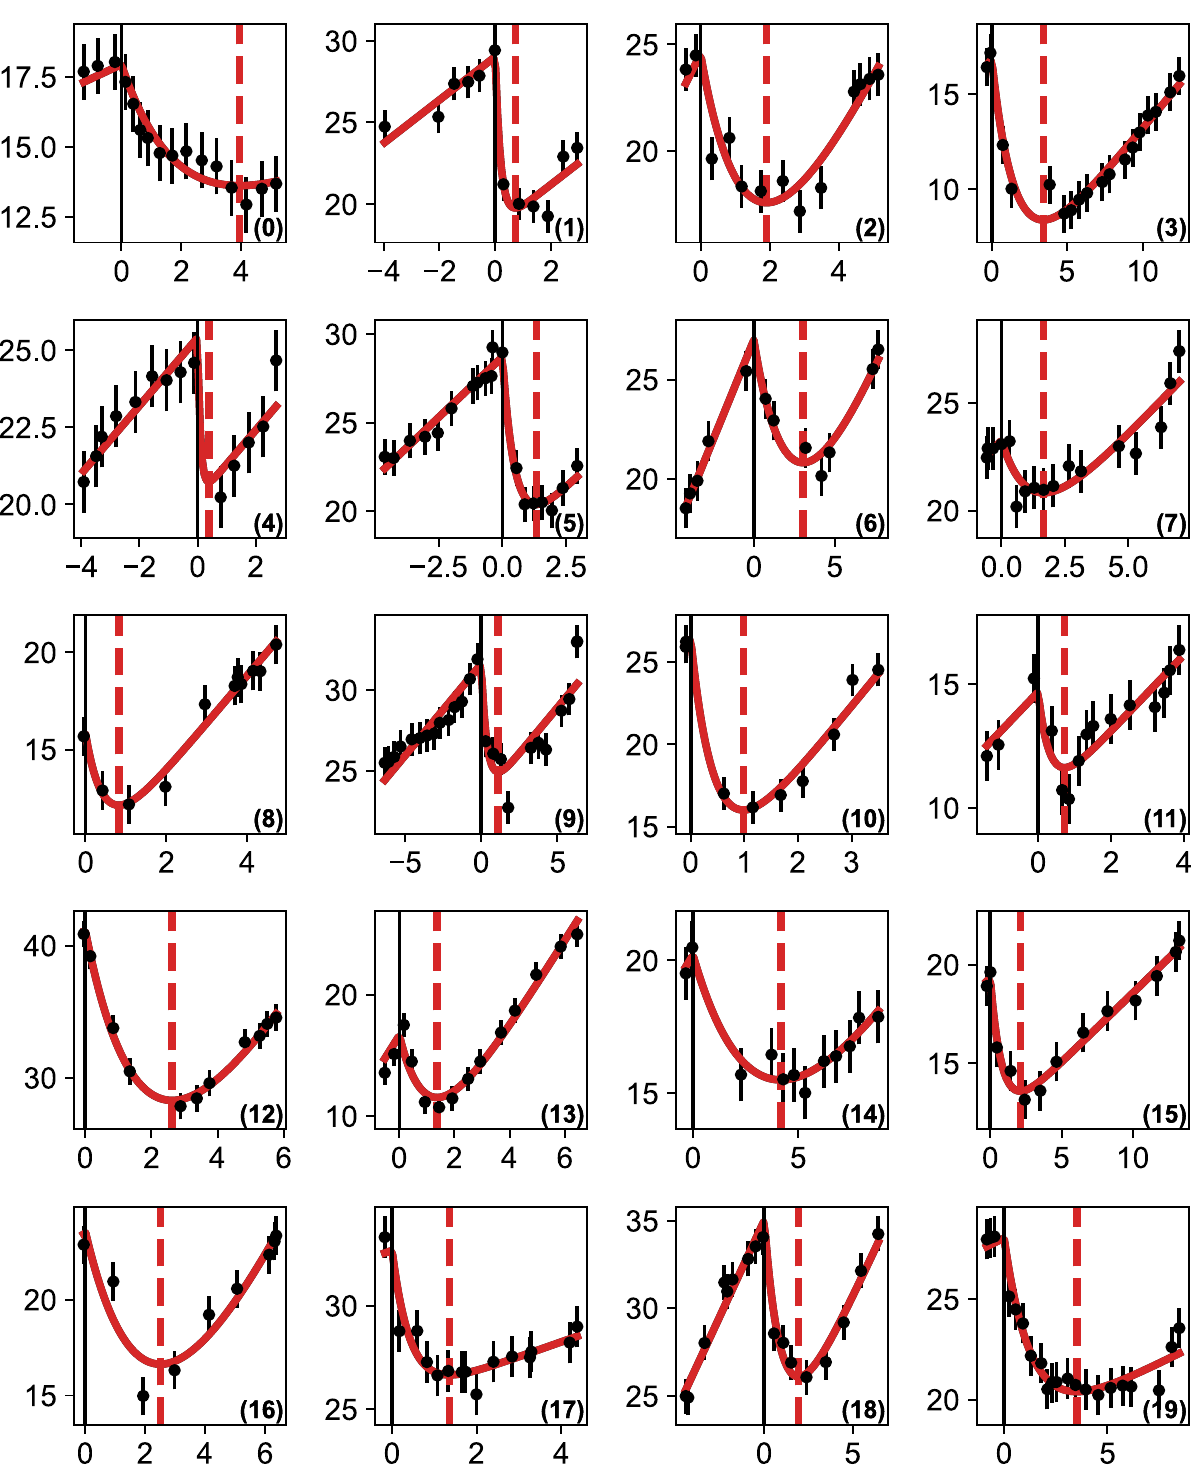
Fig 2. Comparison between the measured values of the tumor radius and the bestfit model for 20 patients. The points represent the measured values and the red line our model obtained by minimizing Eq (5). The abscissa represent time in years (with the origin set at RT) and the ordinate the tumor radius (in mm). The error bars on the measurements are of 1 mm. The dashed vertical red line shows the model minimum, i.e. the moment regrowth starts.